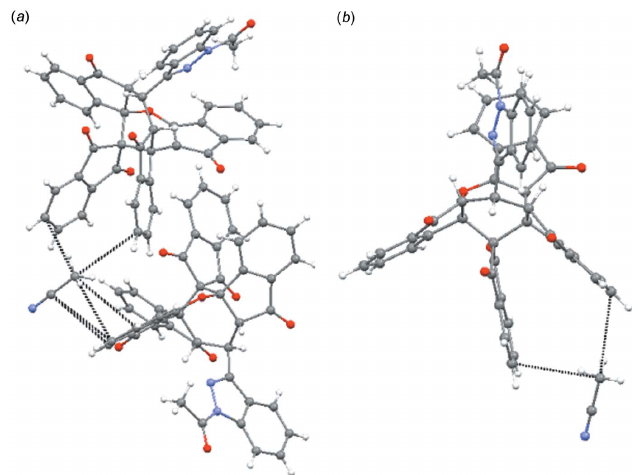
Figure 4 ( a ) van der Waals interactions between the acetonitrile molecules and the title compound: one acetonitrile molecule interacts with up to three arms. ( b ) Illustration of the rigidity that is enforced upon two arms of the title compound as a result of van der Waals interactions.